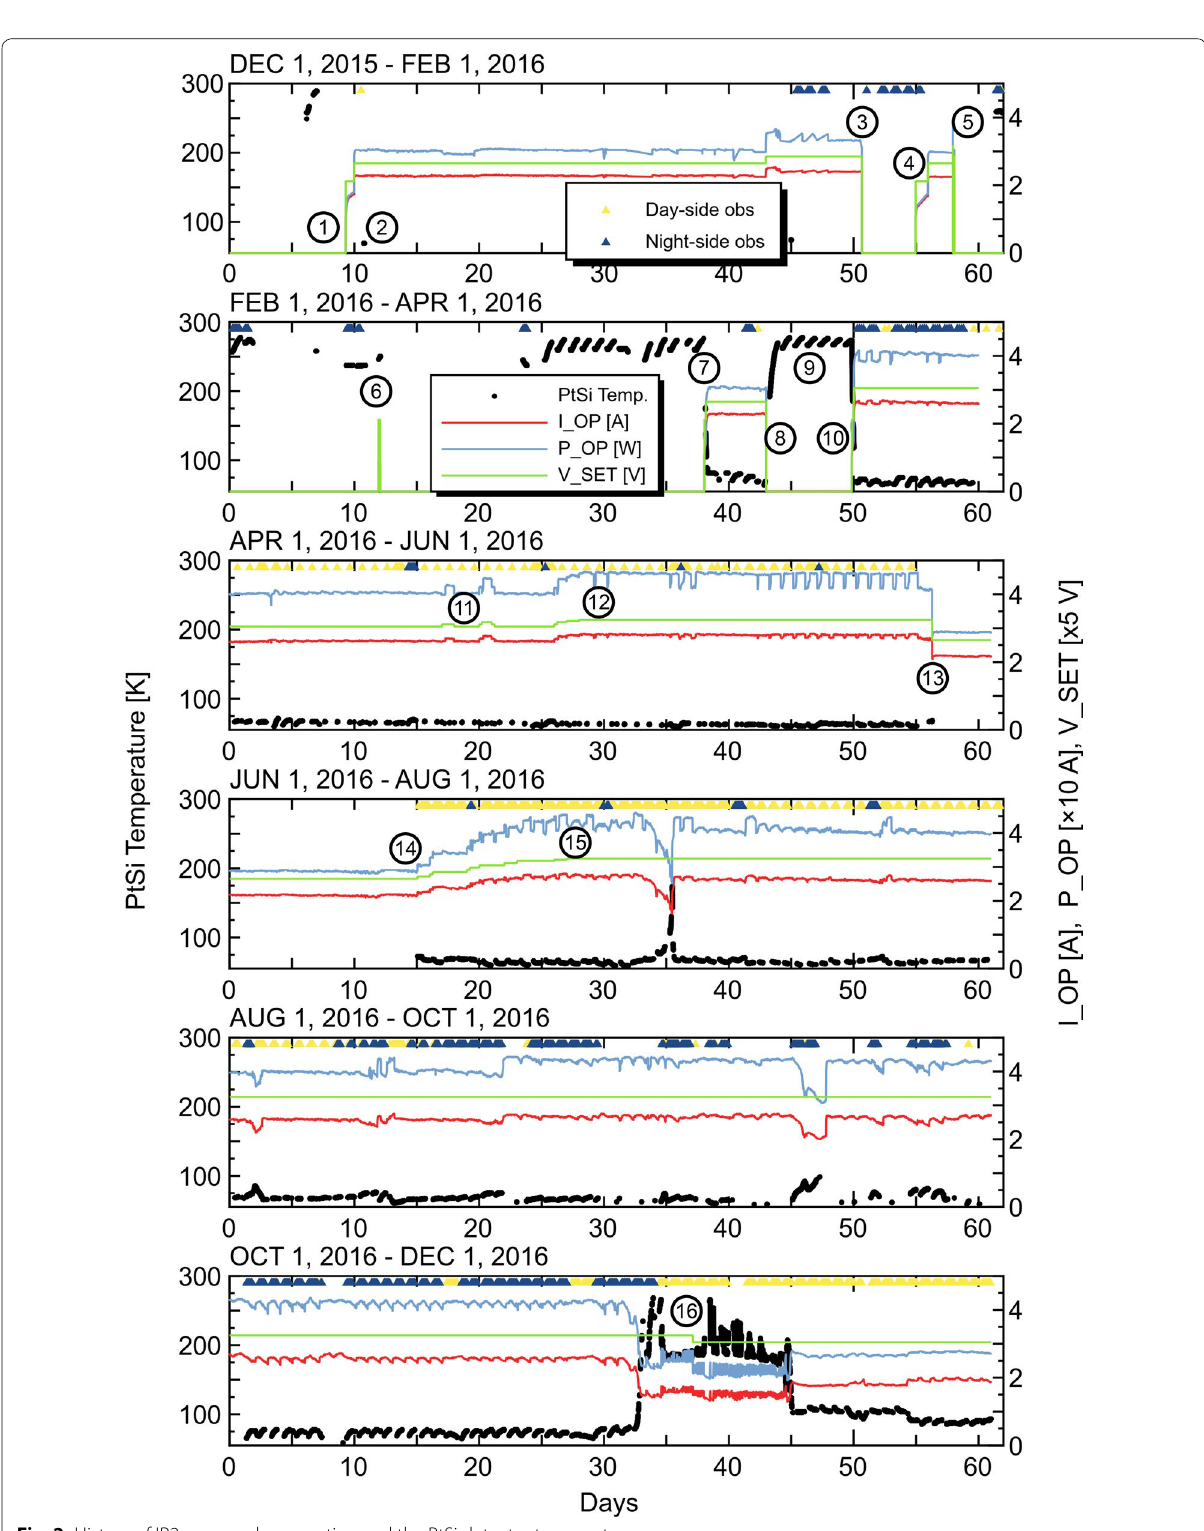
Fig. 2 History of IR2 cryo‑cooler operation and the PtSi detector